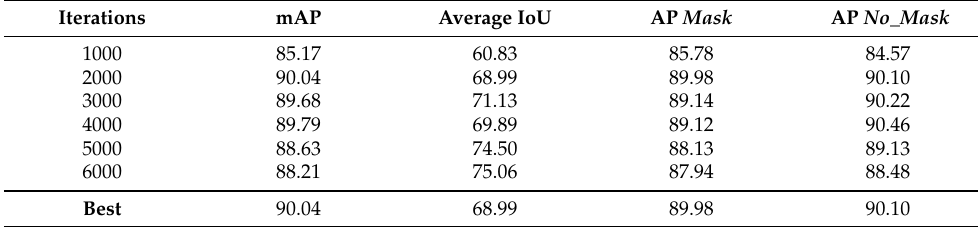
Table 5. Performance of